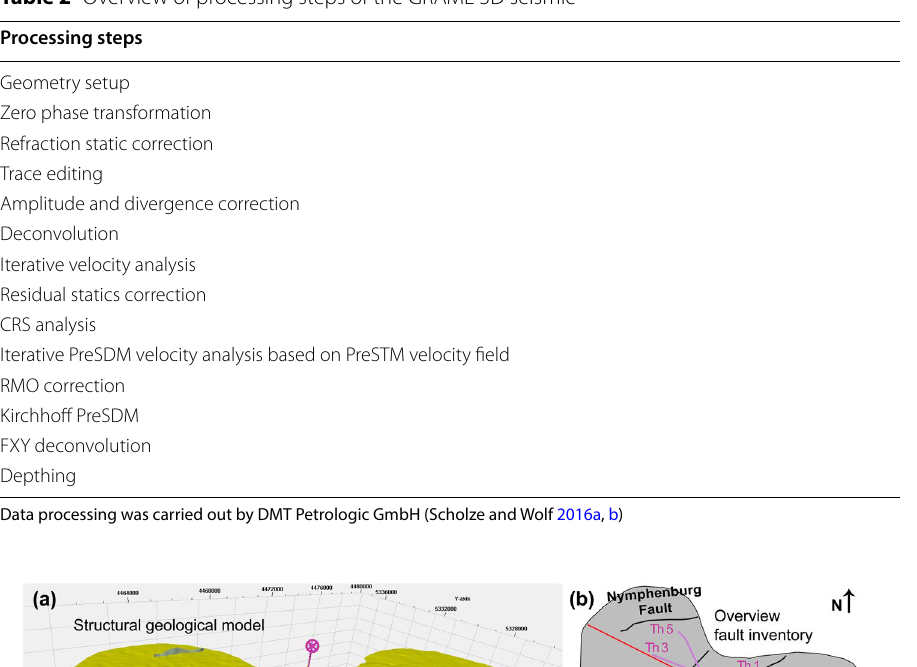
Table 2 Overview of processing steps of the GRAME 3D seismic